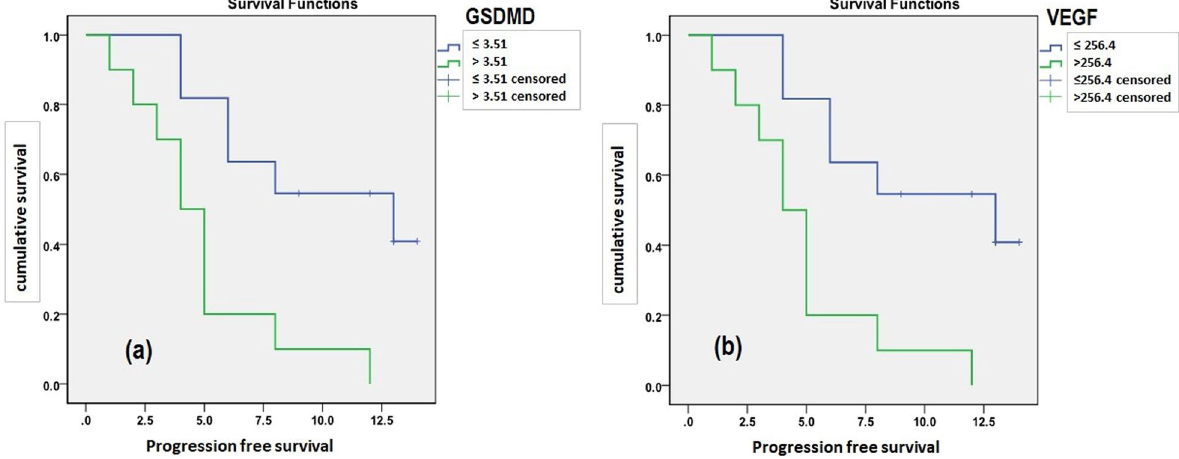
Fig. 4 Relation between a GSDMD and b VEGF with progression‑free survival among malignant pleural effusion